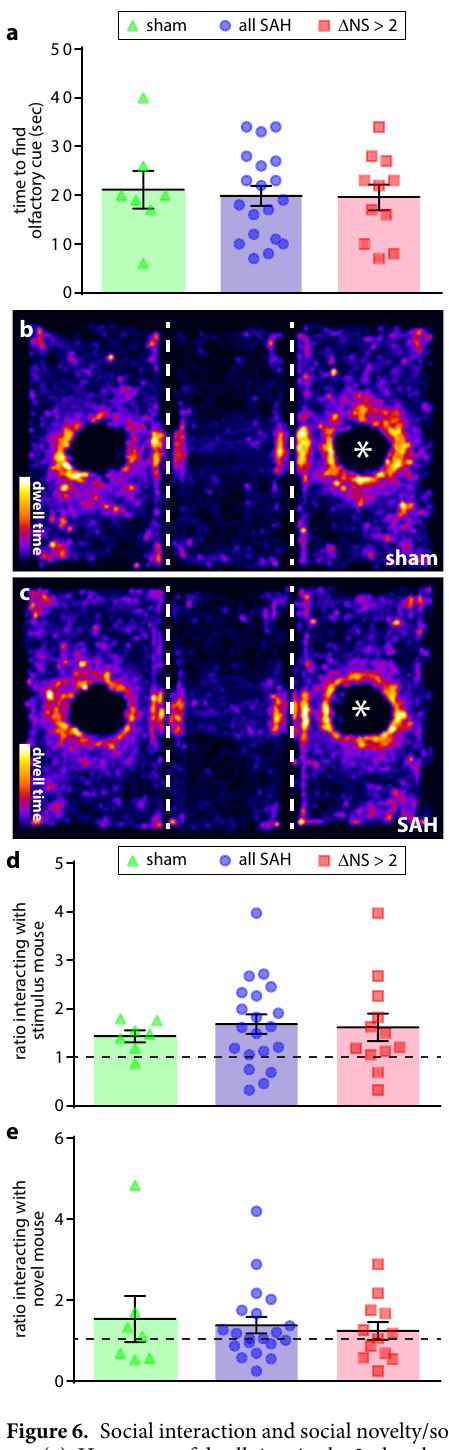
Figure 6. Social interaction and social novelty/social memory. Measurement of time to find a buried olfactory cue ( a ). Heat maps of dwell time in the 3-chamber social interaction test ( b , c ). Dotted lines indicate chamber divisions. Asterisk indicates location of stimulus mouse (dummy mouse placed into opposite chamber). Quantification of ratio of time spent interacting with stimulus mouse vs. dummy mouse ( d ), dotted line indicates no preference). Ratio of time spent interacting with novel stimulus mouse vs. original stimulus mouse ( e ), dotted line indicates no preference). t-test with Holm-Bonferroni correction for multiple comparisons ( a , d ). Mann-Whitney U test with Holm-Bonferroni correction for multiple comparisons ( e